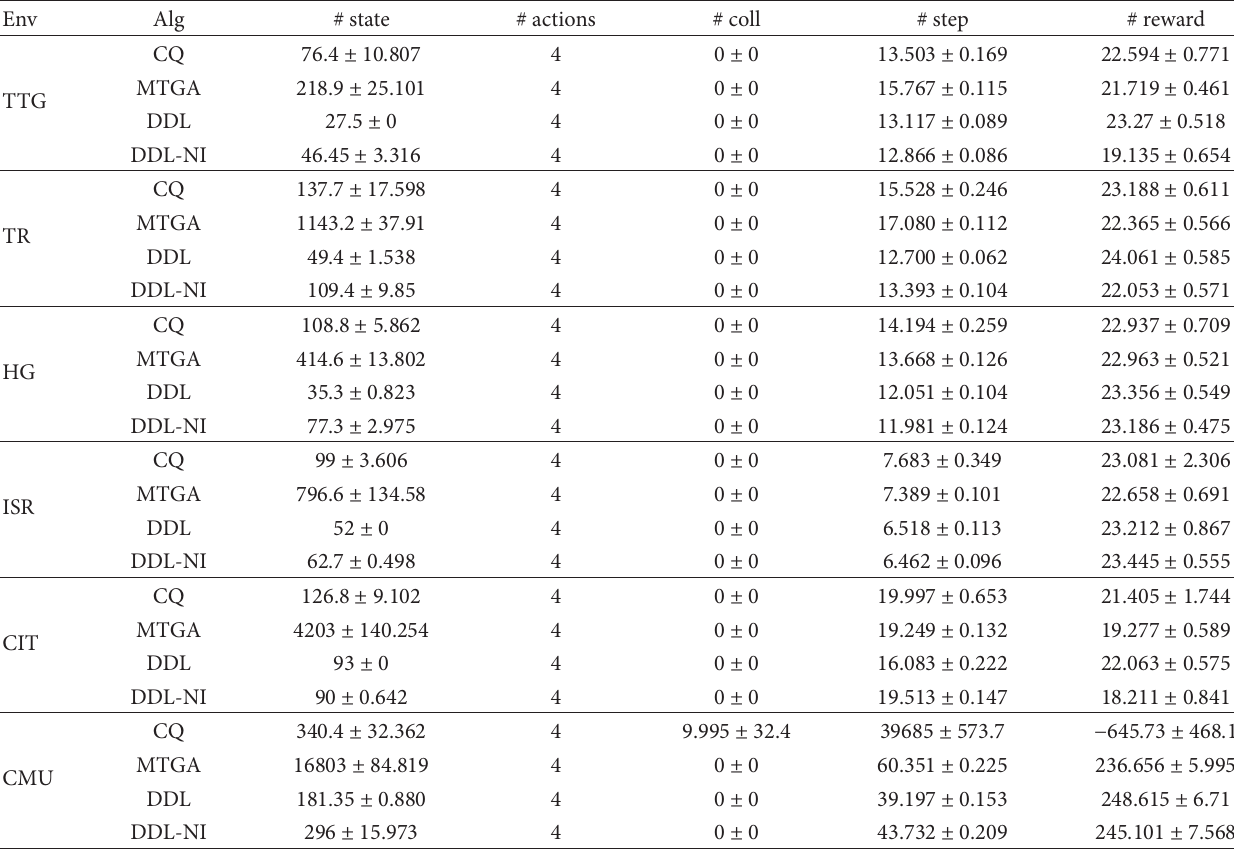
Table 1: Results of final learned policy by the tested approaches in the different 2-agent games.